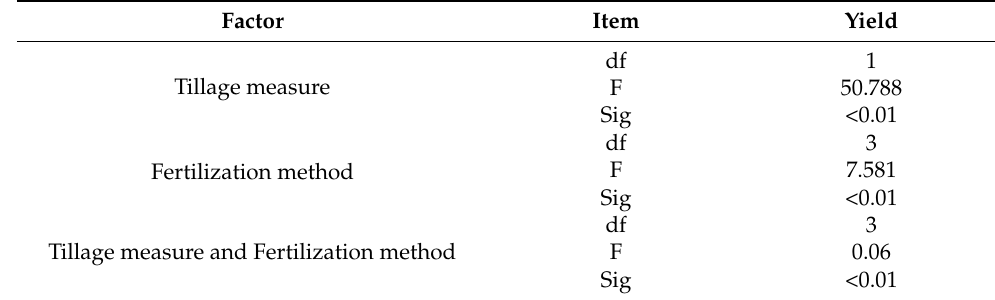
Table 7. Two-way factor ANOVA of spring wheat yield under different